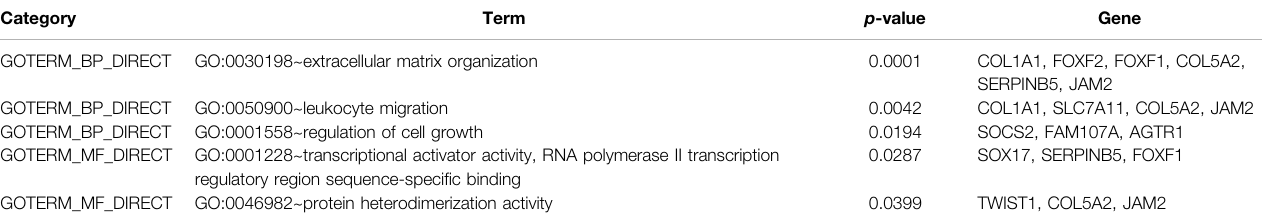
TABLE 7 | GO analysis of selected genes. Category Term